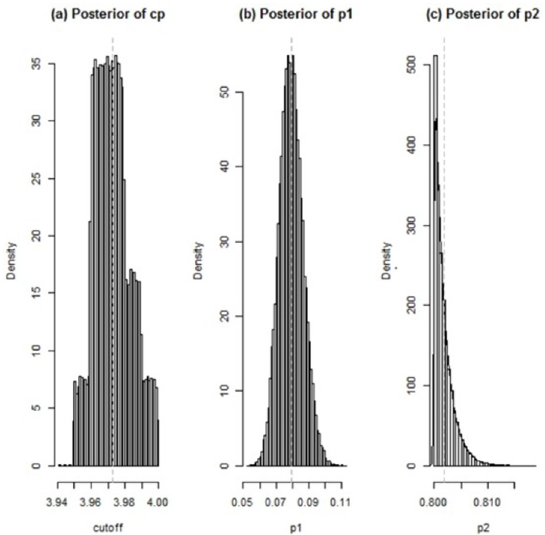
Fig 1. Plot of the posterior distribution for the parameter cp (a), p 1 (b), p 2 (c) estimated by the Bayesian model. The vertical lines denote the median of the distribution.